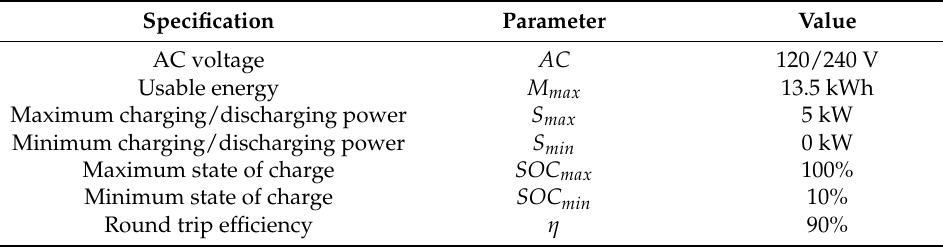
Figure 2. System configuration of home-connected PV and BESS. Table 1. The specification of the battery energy storage